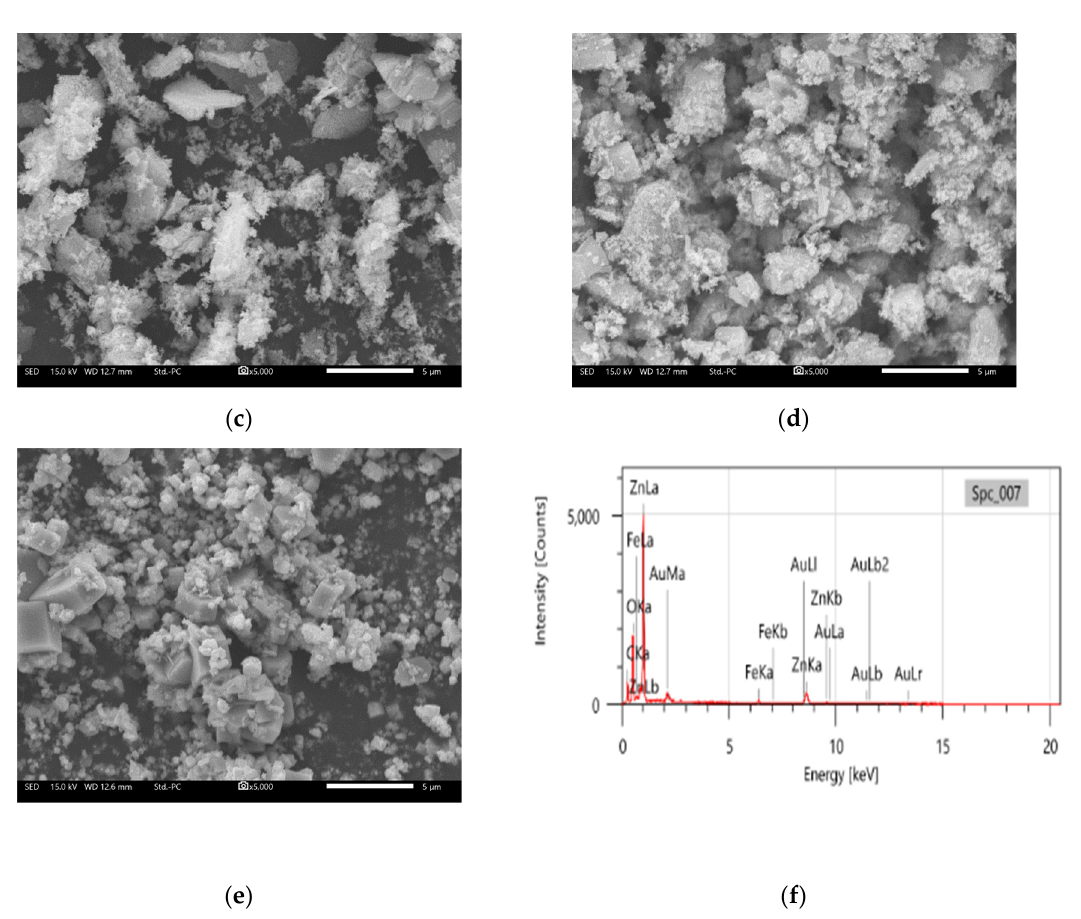
Figure 4. SEM images of ZnO samples heat treated at ( a ) 200 °C, ( b ) 400 °C, ( c ) 500 °C, ( d ) 600 °C and ( e ) 800 °C and ( f ) EDX test results for ZnO samples at a temperature of 600 °C. Table 3. Results of the SEM-EDX quantitative analysis of the ZnO 600 °C sample composition.